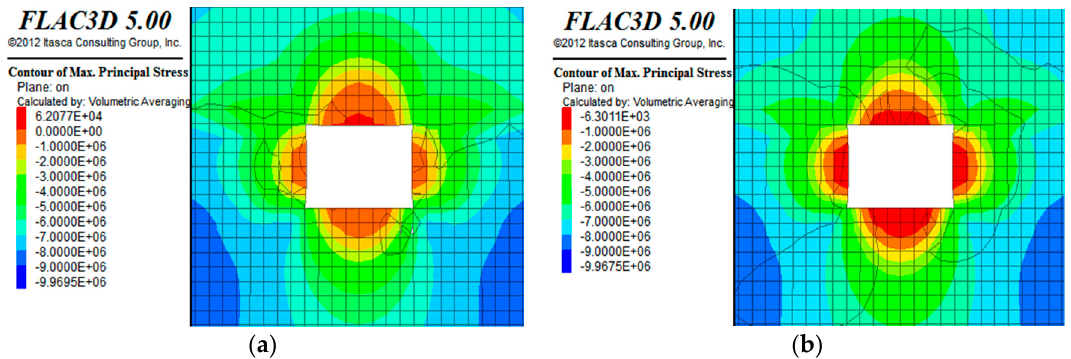
Figure 11. Nephogram of the maximum principal stress with or without bolt support. ( a ) Without bolt support; ( b ) With bolt support.